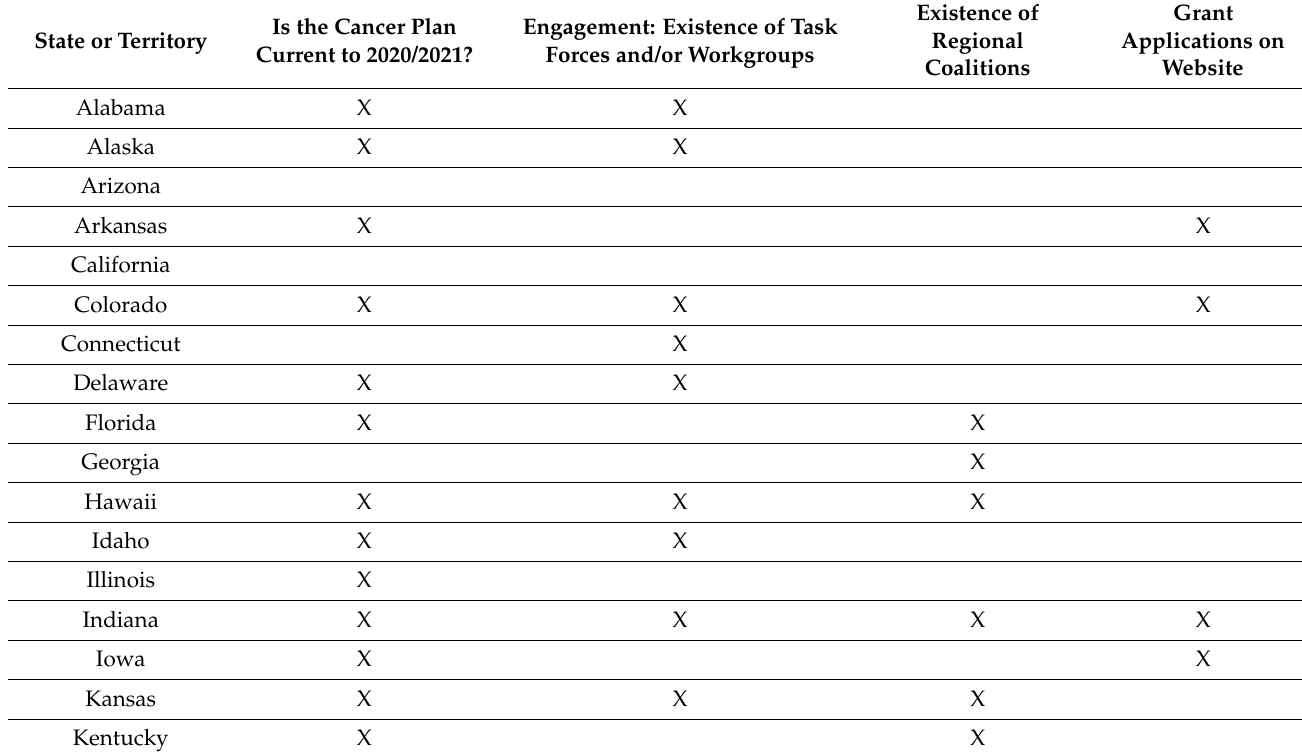
Table 2. Analysis of State Cancer Plans in the United